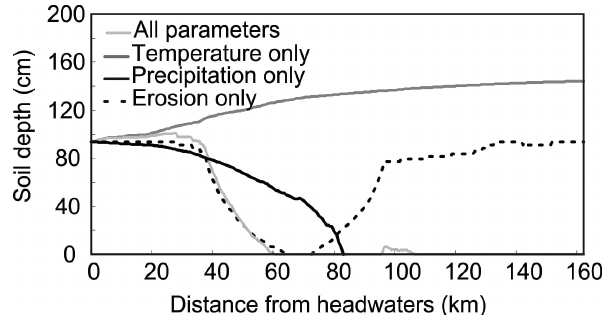
Figure 5. Sensitivity of the Norton et al. (2014) soil production model to each input parameter for the longitudinal profile of the Pisco river. The light grey line shows predicted soil thickness in the downstream direction using all parameters. We then held all other variables constant and allowed the temperature (darker grey line), precipitation (black line), and erosion (dashed line) to change